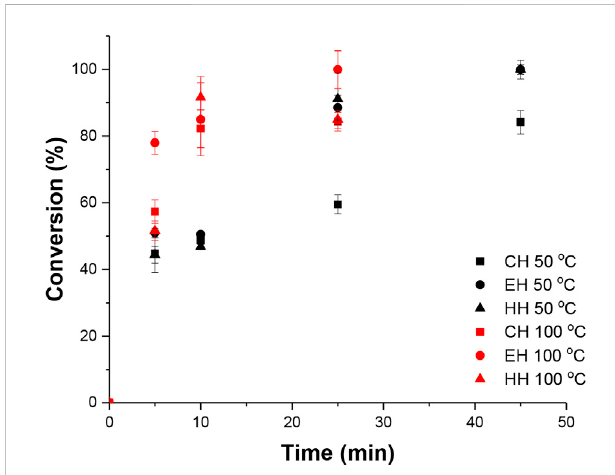
FIGURE 3 Comparison of conversion versus time plots for ROP of CL in CH (n = 3) using FeCl 3 between 50 ° C and 100 ° C.